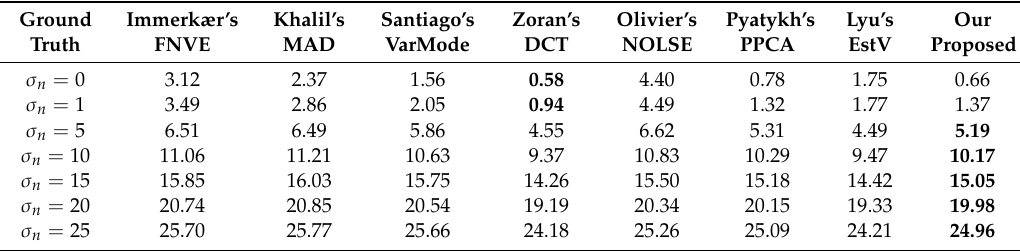
Table 3. The results of di ff erent AWGN estimation algorithms on the Berkeley segmentation dataset (BSD) images. Ground